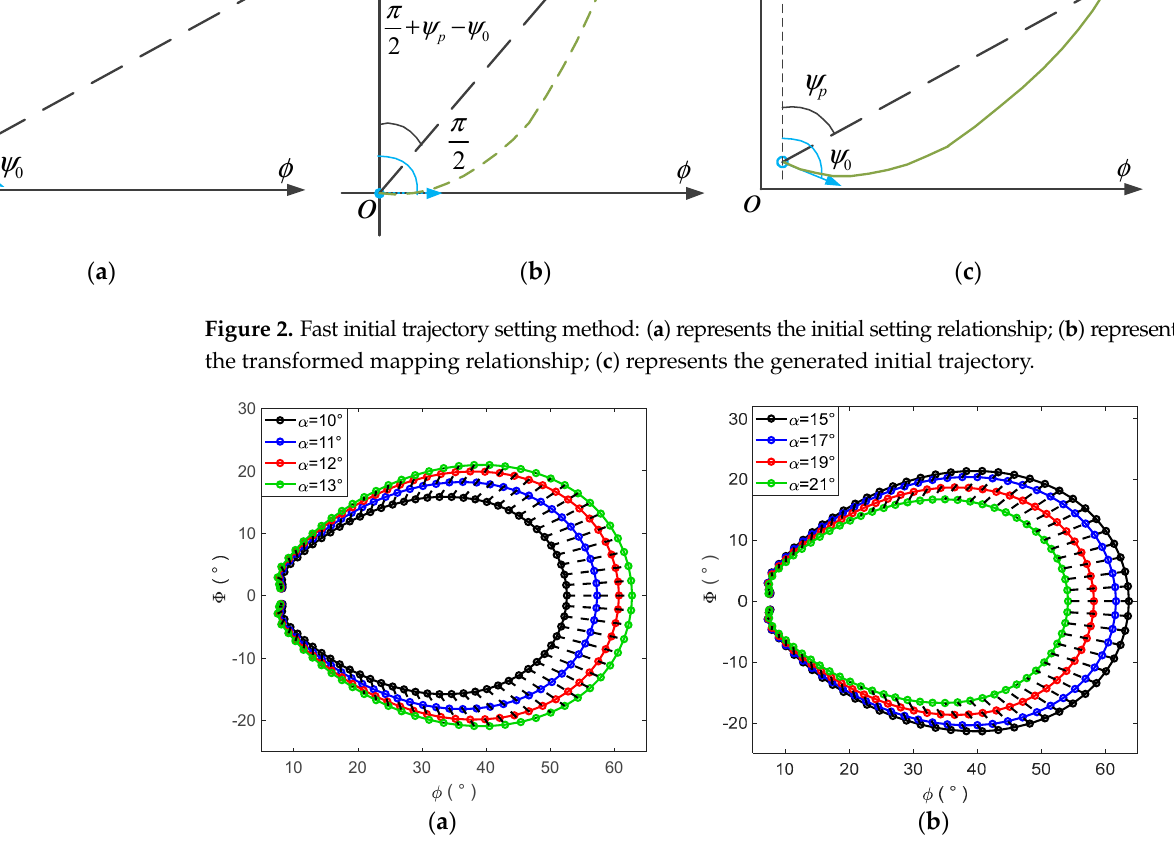
Figure 2. Fast initial trajectory setting method:( a ) represents the initial setting relationship; ( b ) represents the transformed mapping relationship; ( c ) represents the generated initial trajectory.